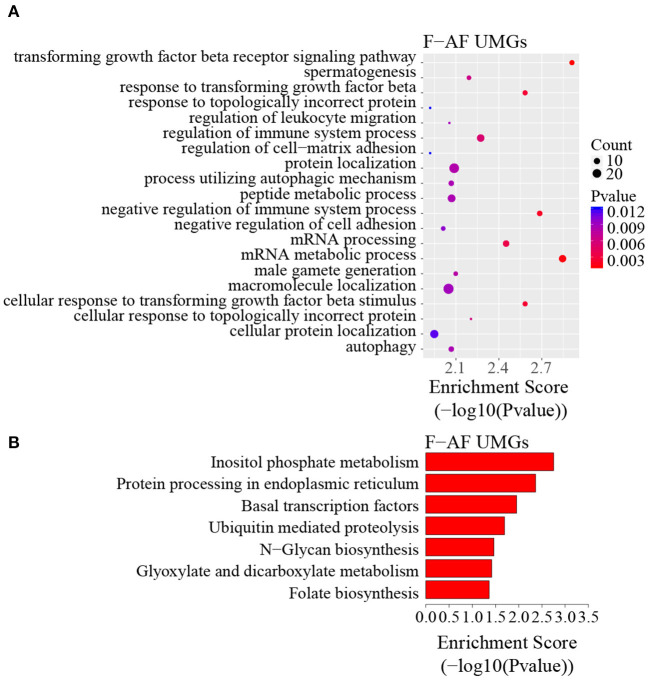
GO biological process and KEGG pathway analyses of unique m6A genes in fat-line broiler chickens. (A) GO analysis of unique m6A genes in the fat line (P < 0.05). (B) Pathway analysis of unique m6A genes in the fat line (P < 0.05).